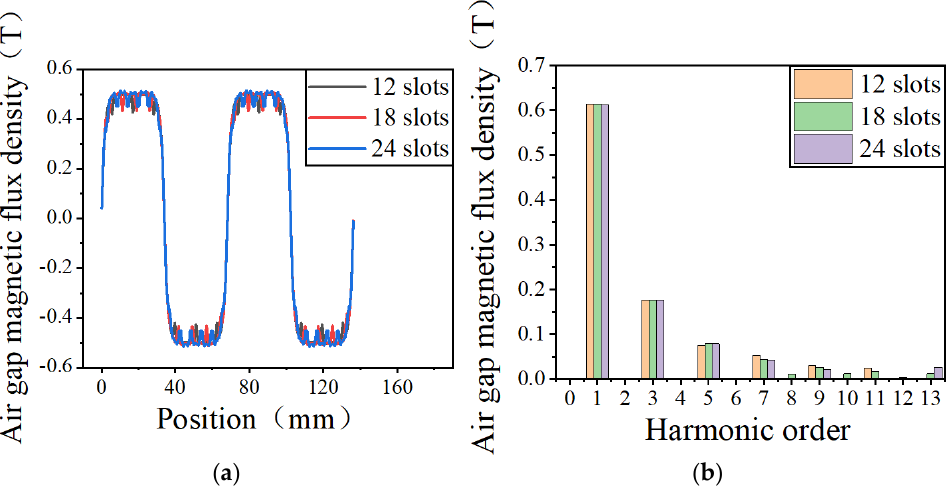
Figure 6. Waveforms and FFT analysis results of air gap magnetic flux density for 12 slots, 18 slots, and 24 slots HSPMMs. ( a ) Waveforms; ( b ) FFT analysis results. Table 4. Performances of 12 slots, 18 slots and 24 slots HSPMMs under full-load